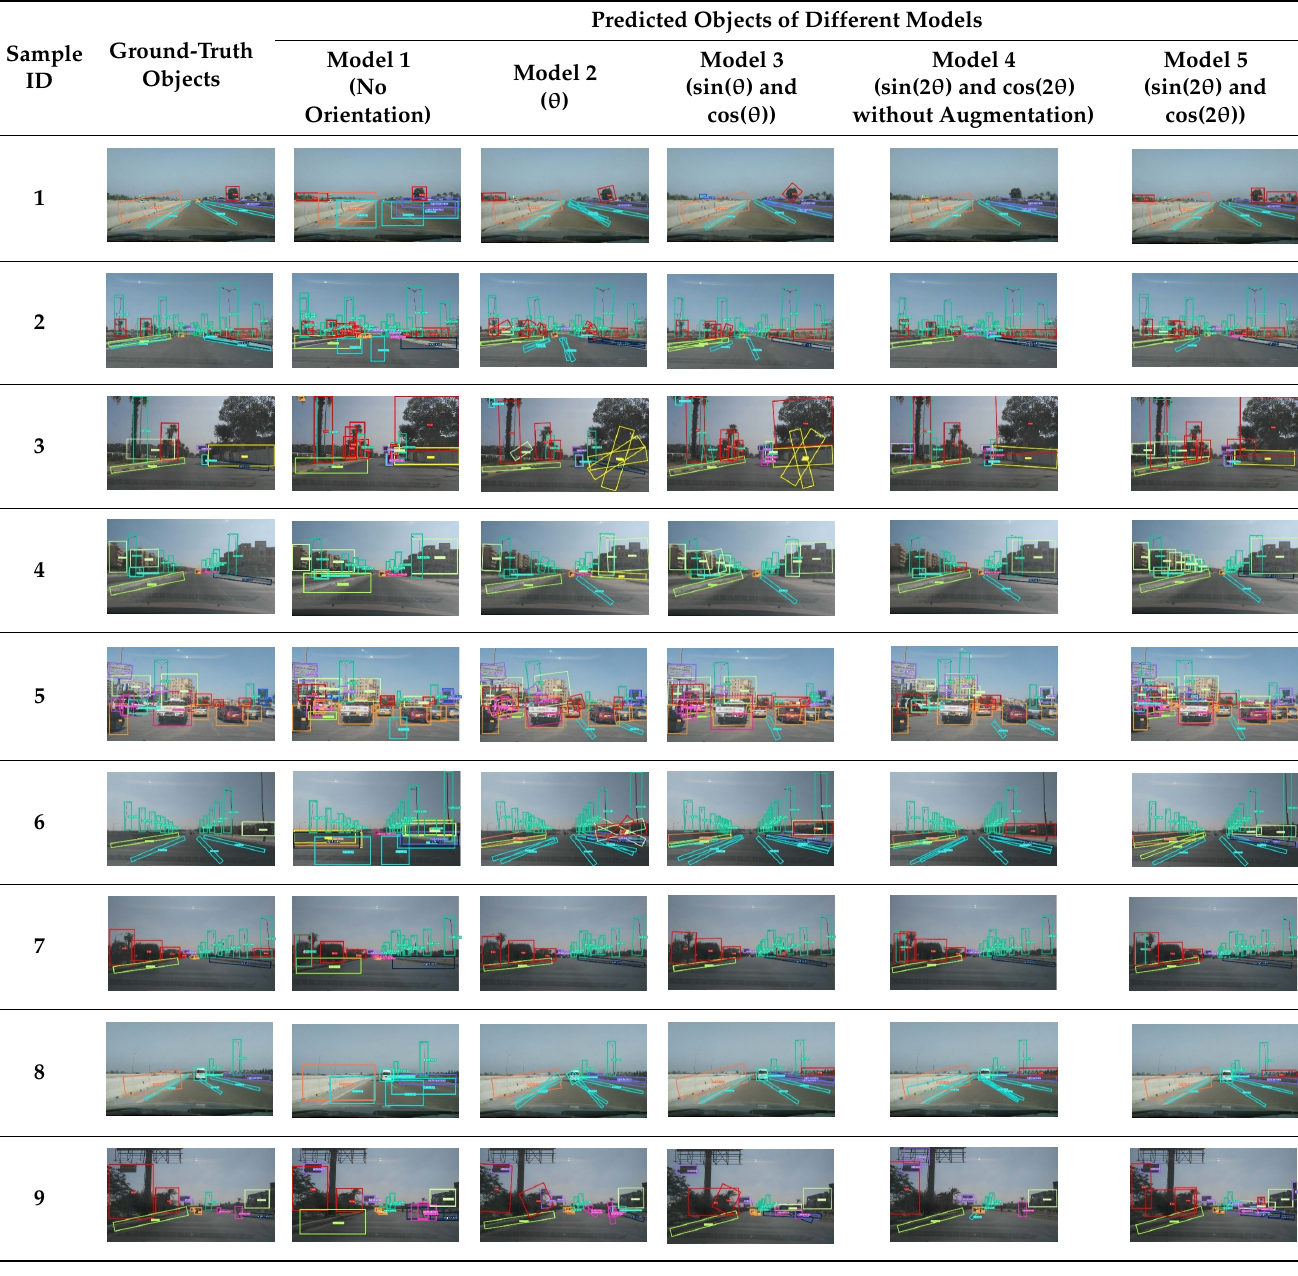
Table 6. Roadway safety features estimation accuracy.